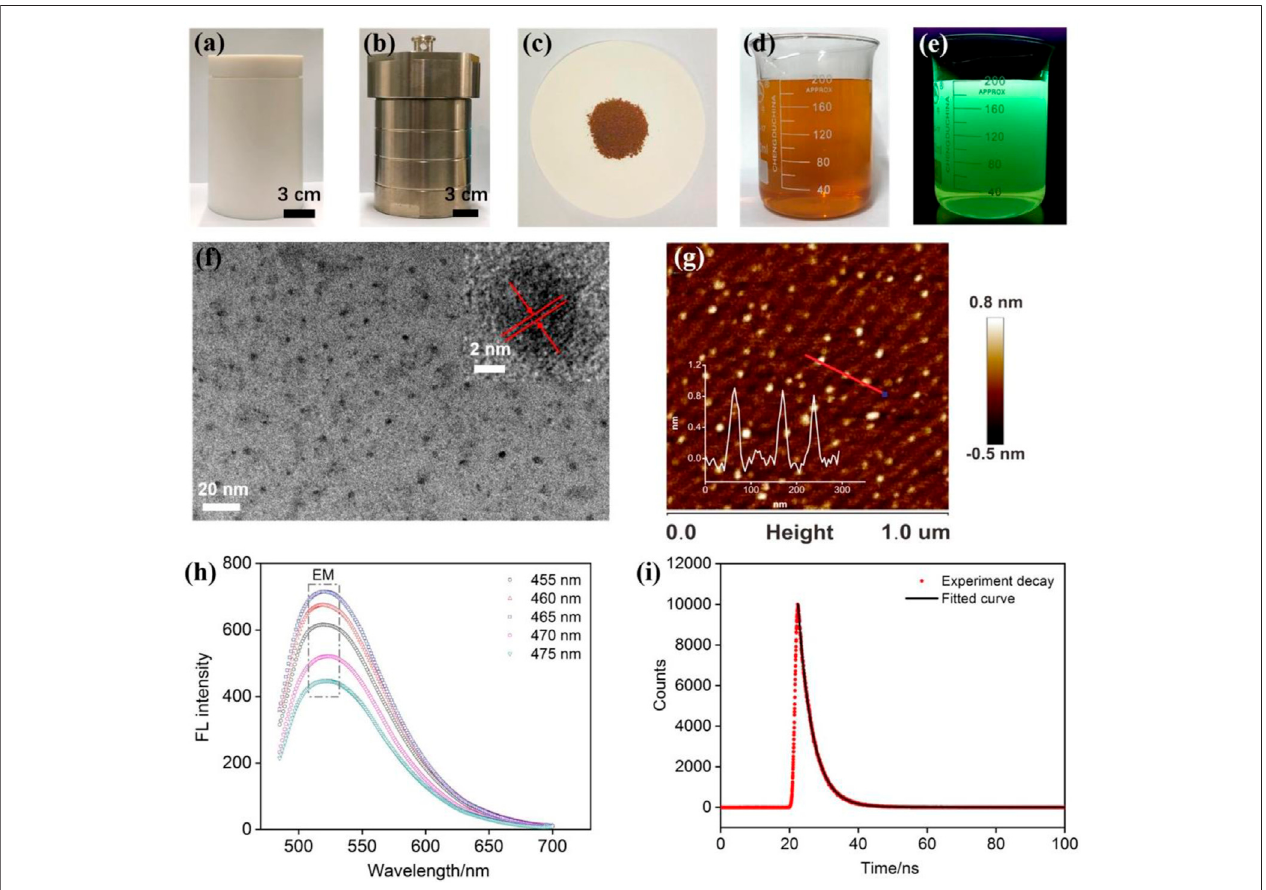
FIGURE 2 | (A,B) Photographs of internal Te fl on reactor (A) and stainless steel housing (B) of an autoclave for the preparation of NGQDs. (C) Powder of NGQDs obtained byone-pot synthesis. (D,E) PhotographsofNGQD solution (2 mg/ml) under visible (D) or 365 nm UV lights (E) . (F) TEM image. InsetsareHRTEM image (top) and size distribution of NGQDs. (G) AFM image. Inset shows the height pro fi le along the red line. (H) Fluorescence emission spectra obtained at different excitation wavelengths. (I) Fluorescence lifetime spectrum.